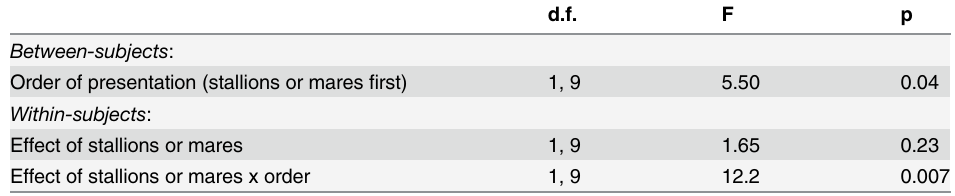
Table 1. MANOVA on mean sperm number after exposure to stallions or to mares. d.f. F